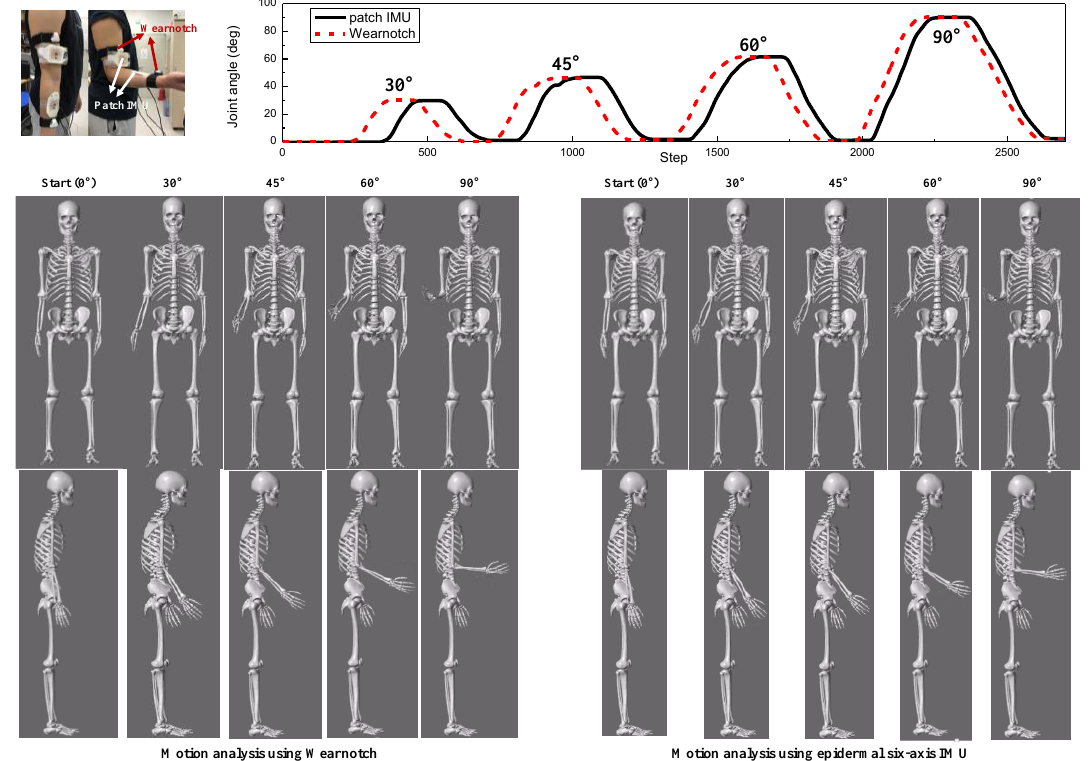
Figure 6. Performance evaluation of wireless epidermal six-axis IMU applied to joint angle estimation using a 3D motion analysis program.